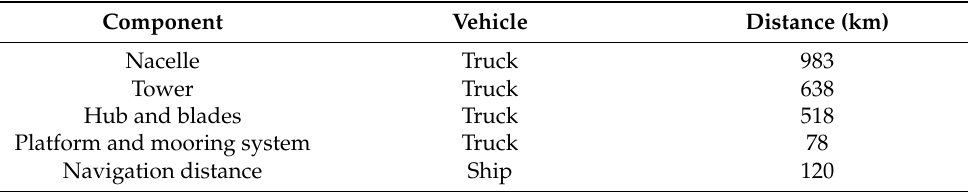
Table 3. Travelled distances on the transportation of each component.